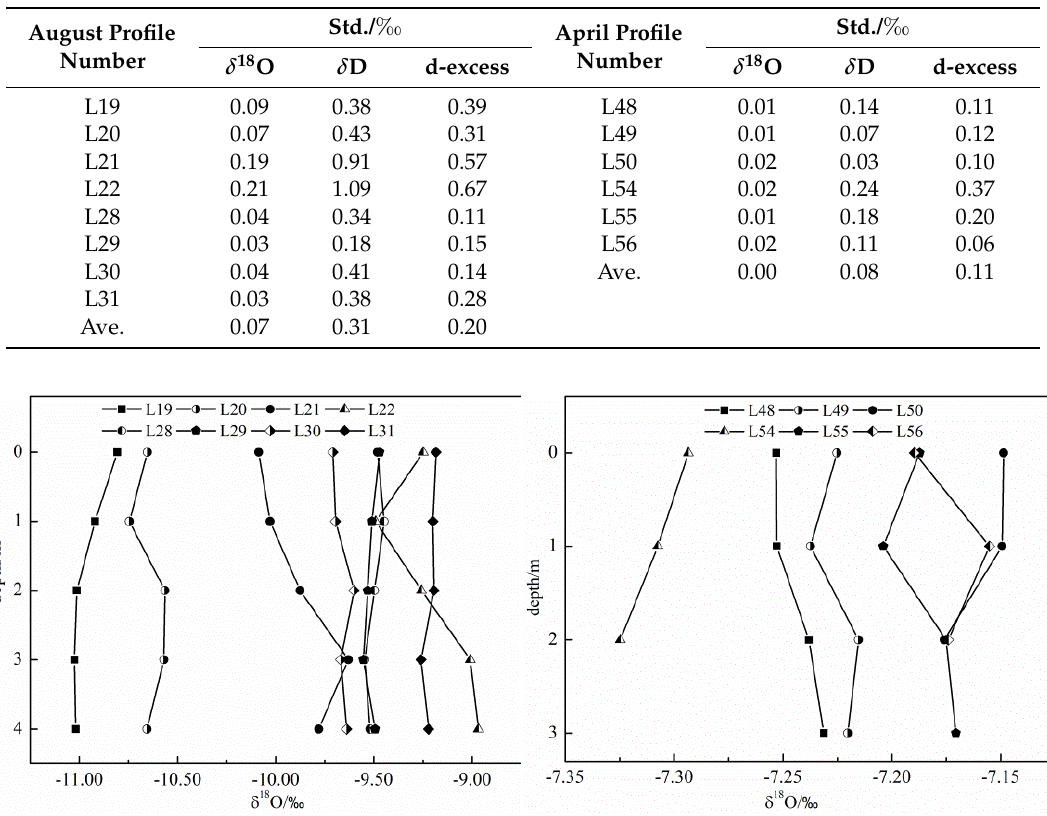
Figure 6. Oxygen isotope composition with depth profiles. Curve diversification of oxygen isotope composition in eight and six depth profiles in August 2014 ( left ) and April 2015 ( right ), respectively.